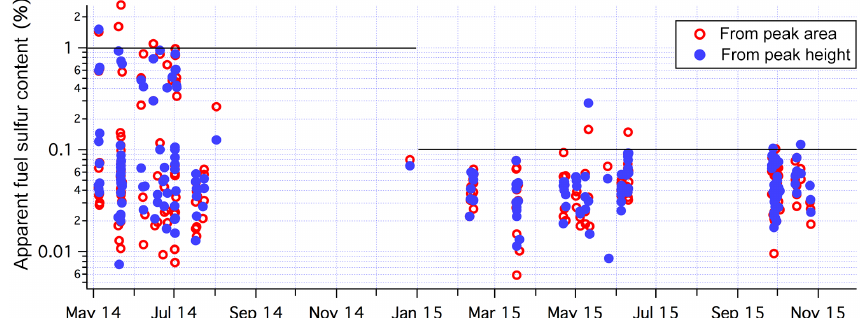
Figure 10. Apparent fuel sulfur content (FSC) estimated from peak areas as well as peak heights of coincidental SO 2 and CO 2 plumes (1min averaged data). Solid horizontal lines indicate IMO fuel sulfur emission content limits in European waters (SECA) regions: 1% SFC in 2014 and 0.1% SFC in